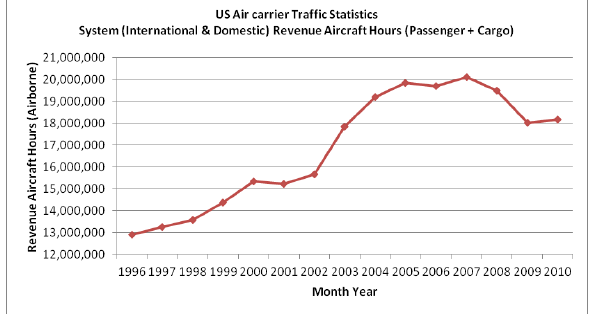
Figure 13: Monthly US system (international and domestic) aircraft airborne flight hours for the period January 1996 through December 2010 for the sum of passenger and cargo flights (source: US Bureau of Transportation